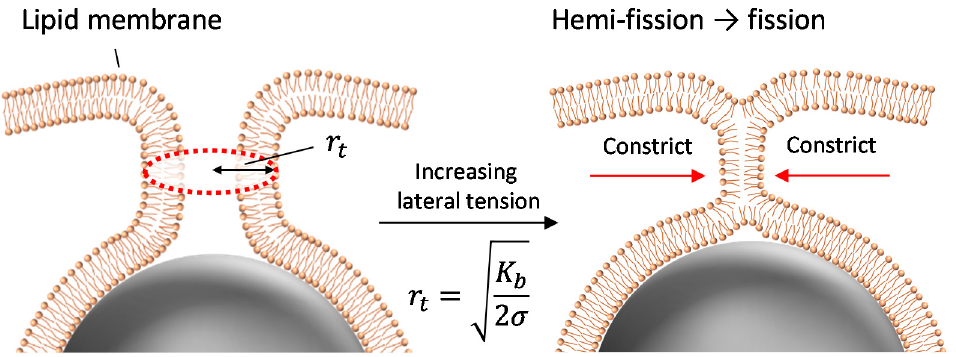
Figure 5. Schematic image of tube constriction and hemi-fission at the neck with increase in lateral tension.